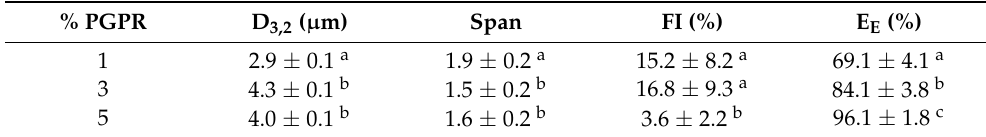
Table 4. Parameters from droplet size distribution (D 3,2 , Span and FI) as well as encapsulation efficiency (E E ) at three different PGPR concentrations (1, 3 and 5 wt.%). Different superscript letters within a column indicate significant differences ( p < 0.05).